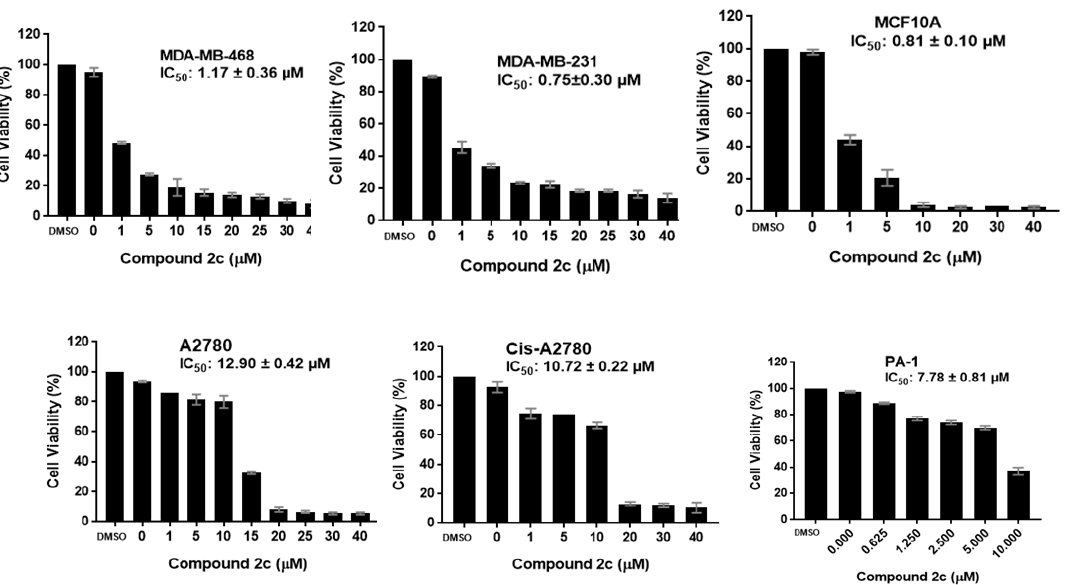
Figure 6. The cell viability (%) relative to untreated control cells of selected breast and ovarian cancer cell lines and breast normal (MCF10 A) cell line following the exposure of various concentrations of compound 2c for 48 h.